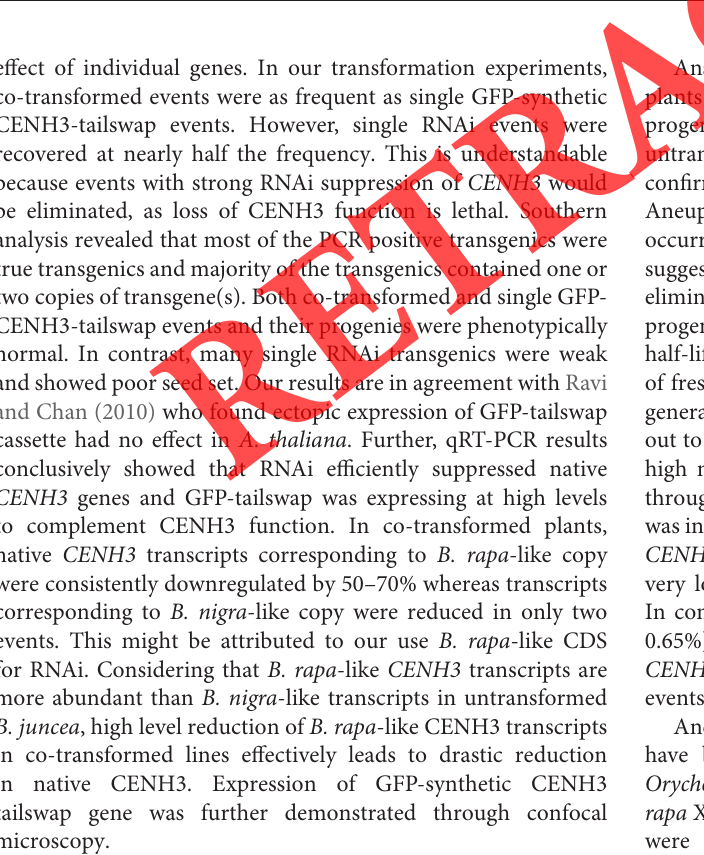
FIGURE 8 | Cytology of progeny plants derived from the cross between Co-transformed and untransformed or GFP-CENH3 tailswap (event # 38) lines. (UT-